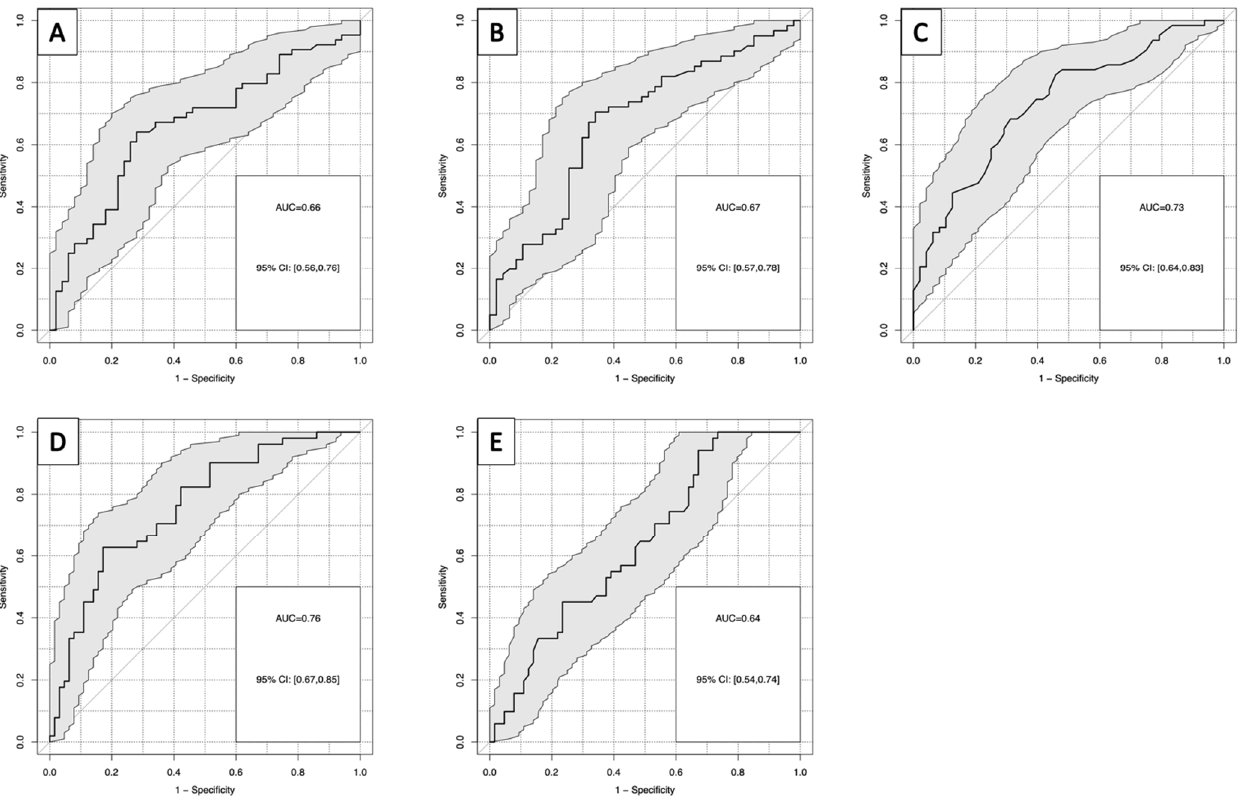
Figure 5. ( A – D ): Receiver operating characteristic curves for the discrimination of severe multiple trauma group and moderate trauma group for: ( A ) cfDNA in plasma; ( B ) cfDNA in serum; ( C ) hemoglobin; ( D ) hemoglobin and cfDNA in plasma; ( E ) random forest model of all investigated parameters for severe multiple trauma group versus moderate trauma group.